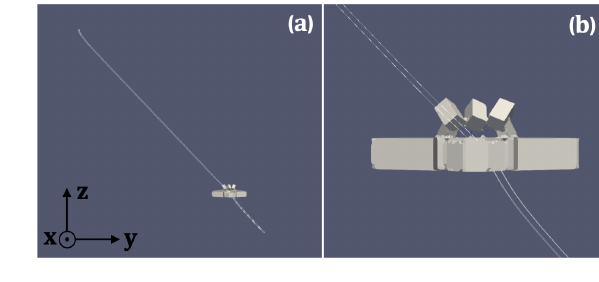
Figure 12. Example of simulated particle trajectories for a horizon- tal wind speed of 1ms − 1